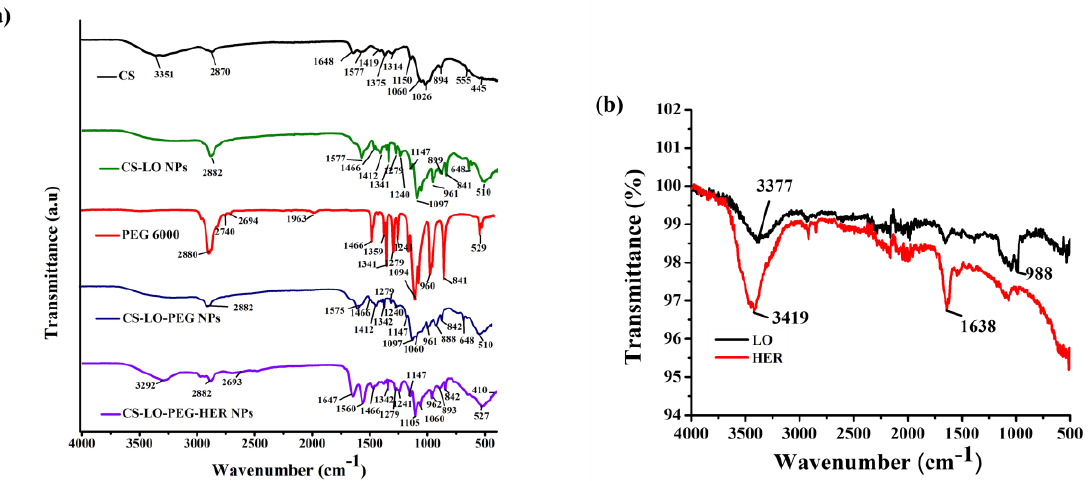
Figure 2. FTIR analysis of herceptin (trastuzumab) functionalized L-lysine α -oxidase loaded chitosan-polyethylene glycol (PEG) nanoparticles. Functional group changes in CS, CS-LO NPs, PEG600, CS-LO-PEG NPs and CS-LO-PEG-HER NPs are shown in ( a ), while LO and HER are shown in ( b ).